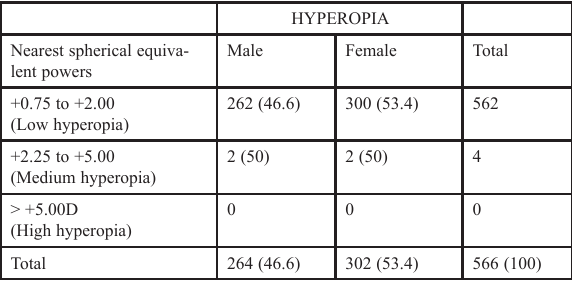
Distribution of the low, medium and high positive refractive powers (F NSE ) among the male and female subjects (percent- ages in brackets). Most of the powers were ≤ +2.00 D .